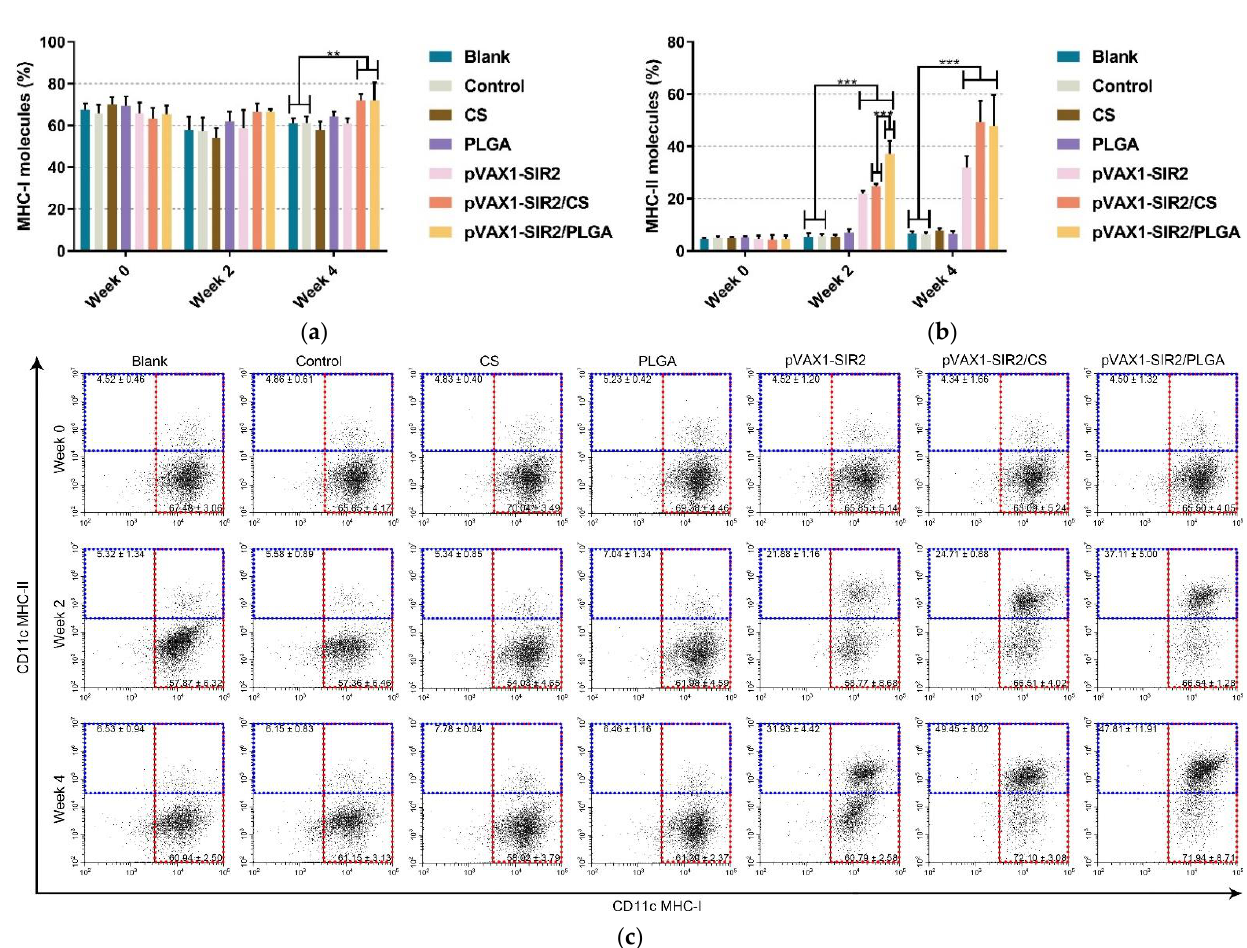
Figure 8. Analysis of MHC molecules on the surface of DCs at week zero, two, and four. The expression of MHC-I and MHC-II molecules was evaluated by flow cytometry. Bar graph showed the ratio of MHC-I ( a ) and MHC-II ( b ) molecules on splenic DCs, and the dot plots ( c ) showed the percentage of CD11c + MHC-I + and CD11c + MHC-II + cells. Each sample was investigated once, and values were analyzed by one-way ANOVA analysis followed by Dunnett ’ s test. Values between the pVAX1-SIR2/CS and pVAX1-SIR2/PLGA group were estimated by the independent t -test. Values were shown as mean ± SD (n = 5). ** p < 0.01 and *** p < 0.001 compared with blank or control group.